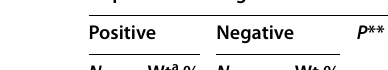
Table 2 Bivariate association between procedures and practices and hepatitis B final result ( n =